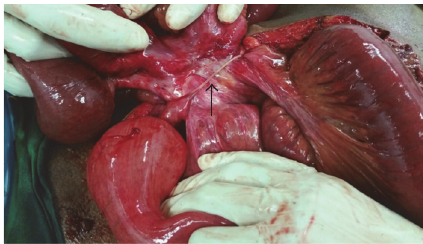
Figure 5: Fibrous band extending from Meckel’s diverticulum to anterior abdominal wall (black